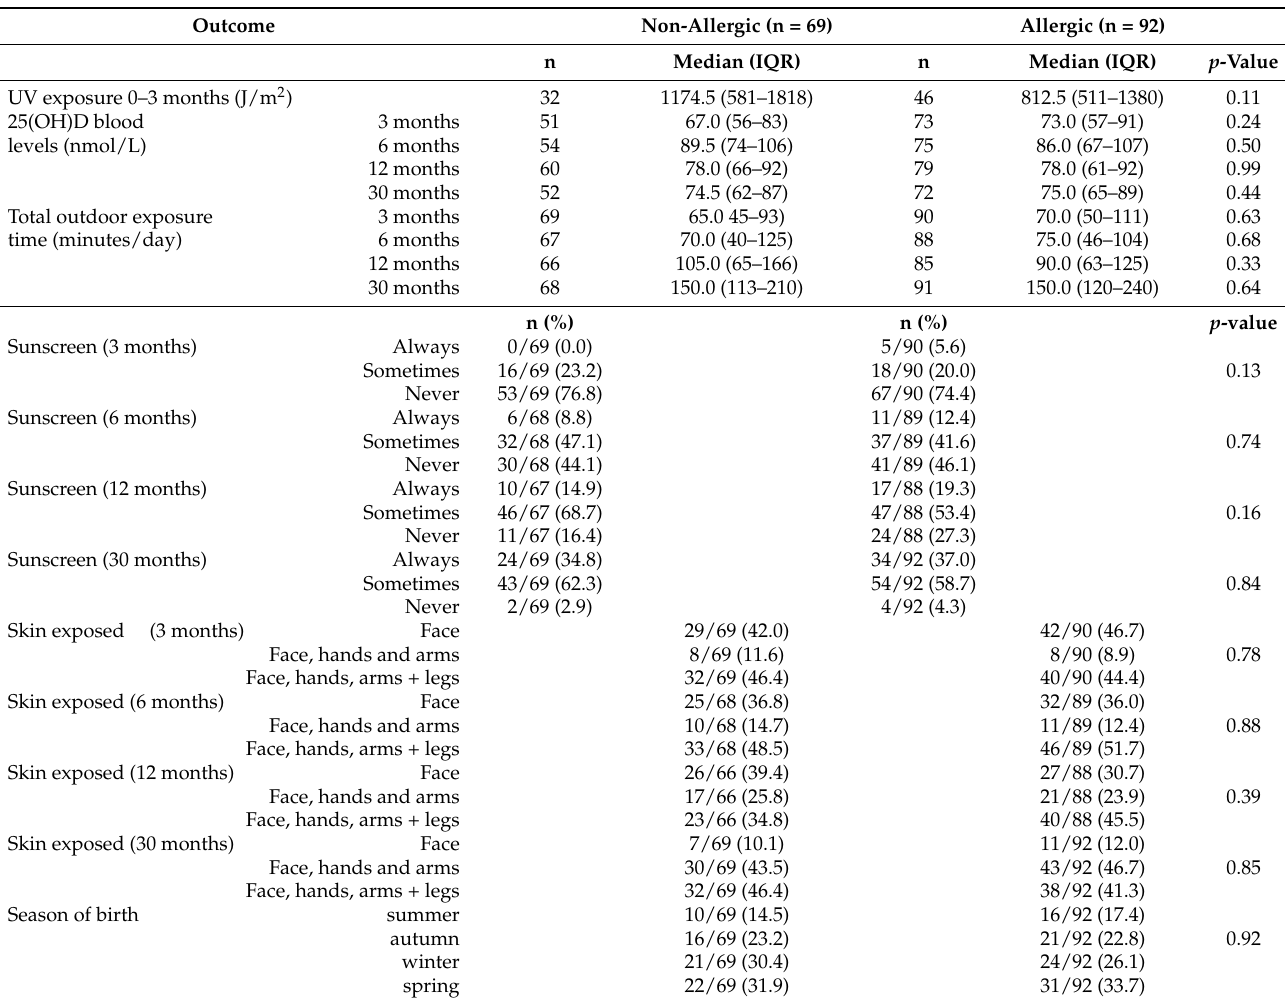
Table 3. Comparison of cumulative allergic outcomes within first 2.5 years of life in association to key risk factors.